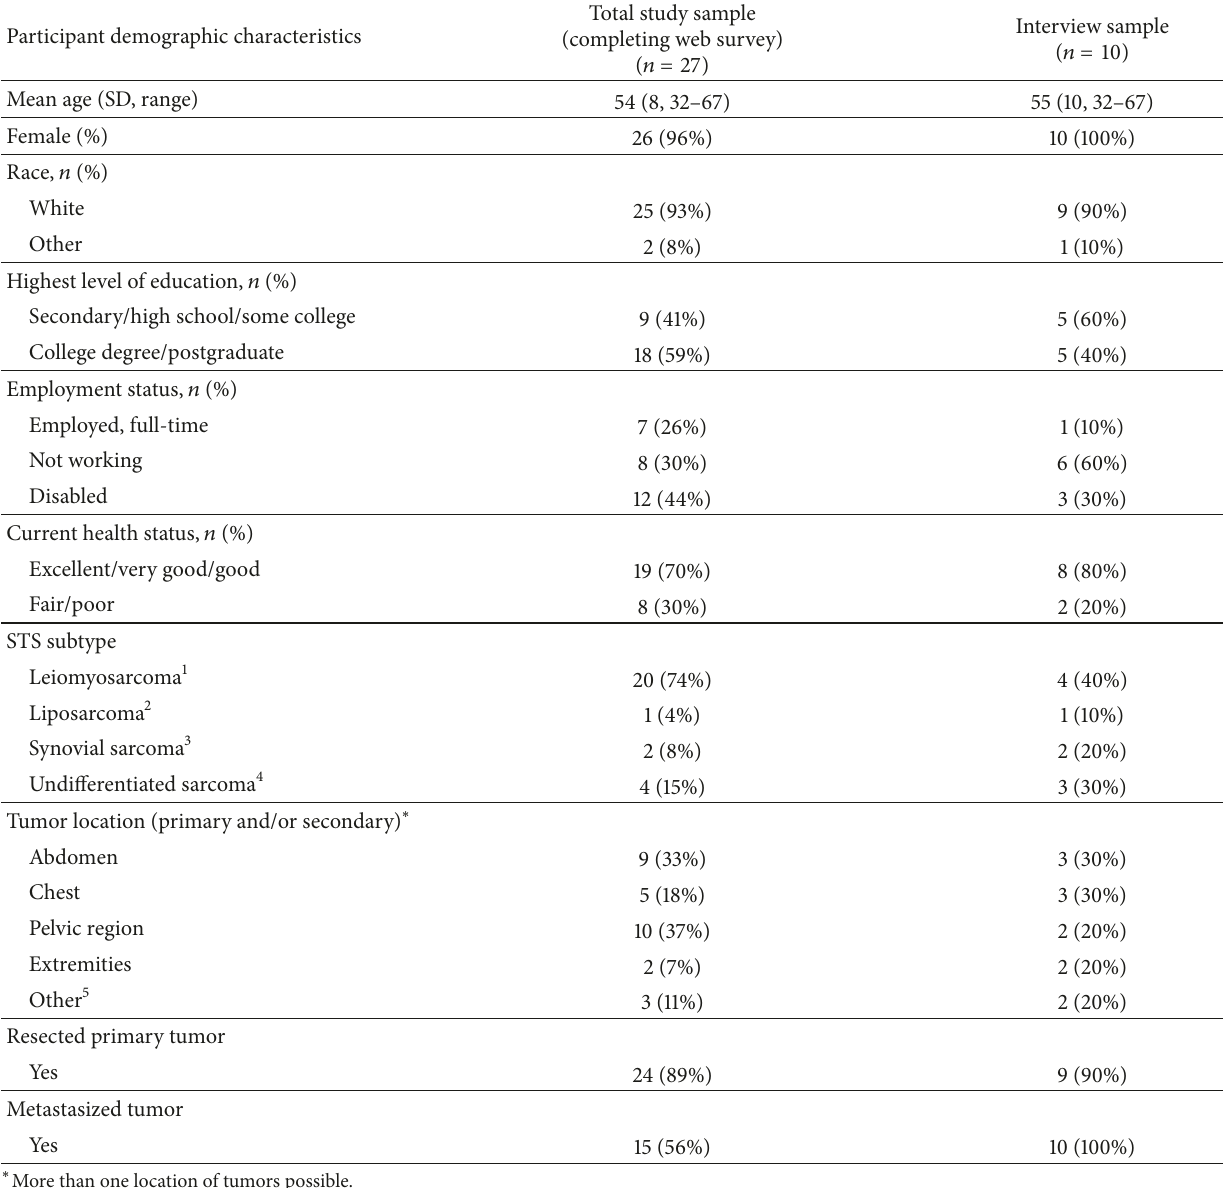
Table 2: Self-reported STS participant demographic